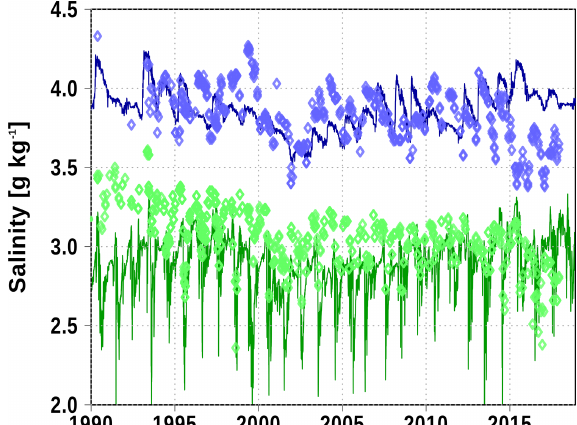
Figure A3. Surface (green) and bottom (blue) salinity at station F9. Solid line: model; diamonds: observations (http://www.ices.dk,